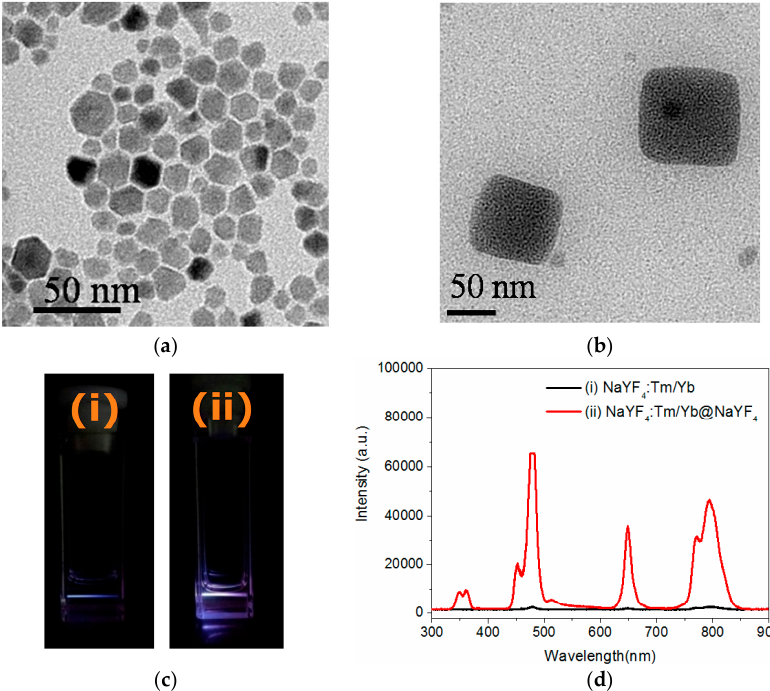
Figure 1. Transmittance electron microscopic (TEM) images of: ( a ) polygonal (small); and ( b ) cubic-like (large) NaYF 4 nanocrystals. The average dimension for ( a ) was calculated based on 100 nanoparticles selected from a TEM micrograph. Upconversion fluorescence images ( c ) and spectra ( d ) of the: (i) core; and (ii) core-shell nanocrystals, under 980-nm laser excitation. The spectra recorded by a CCD imaging spectrometer exhibits UV, blue, red, and NIR wavelengths simultaneously.